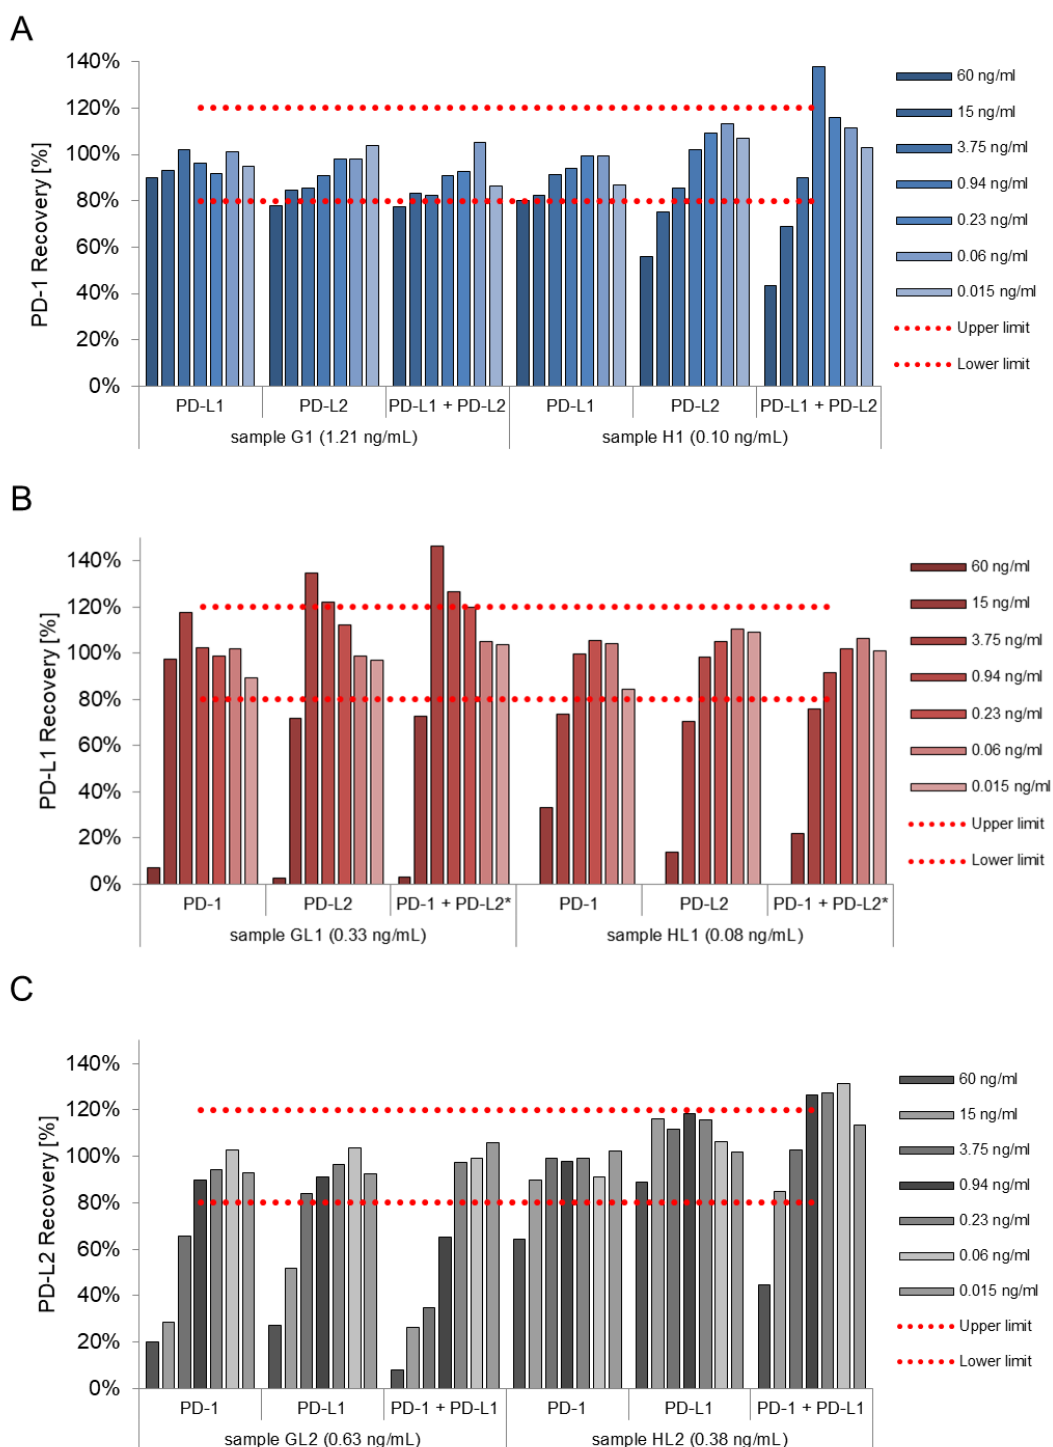
Figure 2. Percentage results of selectivity experiment in heparin plasma for PD-1 ( A ), PD-L1 ( B ) and PD-L2 ( C ). * A starting concentration of 30 ng/mL for both proteins was used.